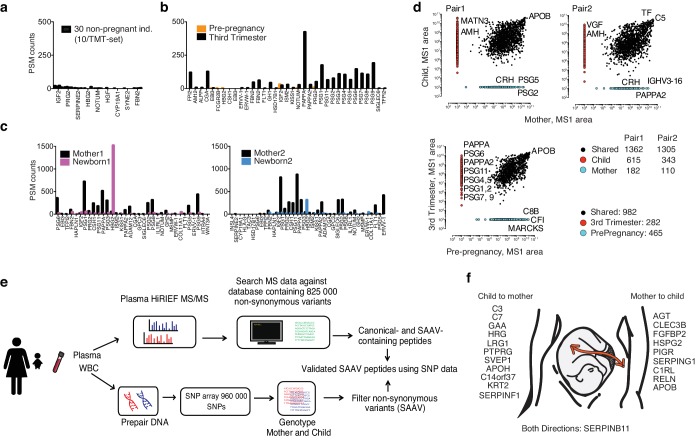
Use of theoretical peptide pI in global and targeted plasma HiRIEF.(a) Placental proteins detected in 30 non-pregnant blood donors. (b) Placental proteins detected at two different time points in one individual, during third trimester and prior to pregnancy. (c) Placental proteins in two pairs of mother and newborn. (d) A comparison of unique and shared plasma protein levels (MS1 area) in mother versus newborn (two pairs), and in one female individual pre-pregnancy versus third trimester. (e) A brief overview of the proteogenomics workflow (f) An illustration of suggested placental leakage proteins and direction of transfer between mother-and-child.